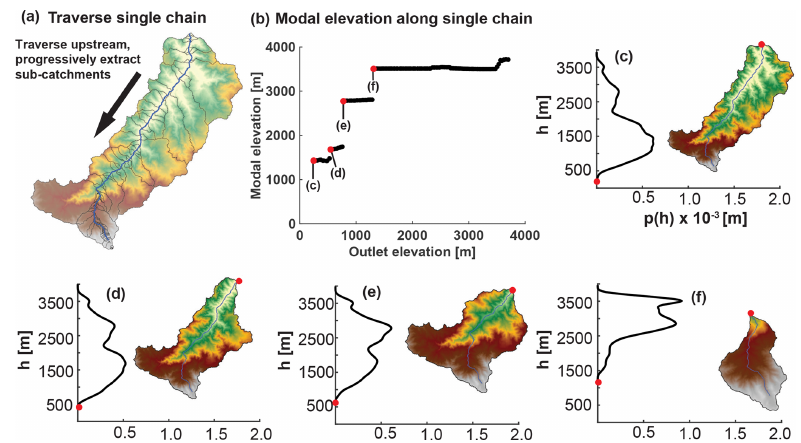
Figure 4. Progressive hypsometry in detail. (a) DEM of one super-catchment from the Talamanca Range. Elevation 0–4000m is yellow through white. The dark blue streamline is an example of one chain along which progressive hypsometry is performed. The bounds of each progressively delineated catchment are drawn in black. (b) Modal elevation (hypsometric maximum) of catchments draining to progressively higher outlet elevations along dark blue streamline in panel (a) . Each subcatchment in panel (a) is represented in panel (b) . The stepped pattern in catchment modal elevation is commonly observed in all landscapes. (c–f) Elevation PDF and DEM of catchments at each jump in modal elevation in panel (b) . Red dots indicate the catchment outlet on both the PDF and DEM and are also represented as red dots in panel (b)